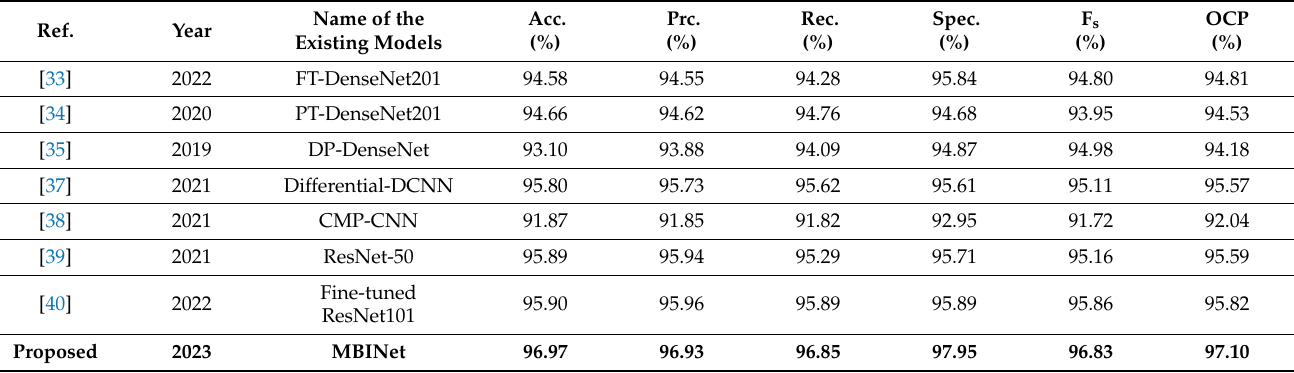
Table 6. Comparison results of the proposed model with the existing models. Bold represents the best-performing